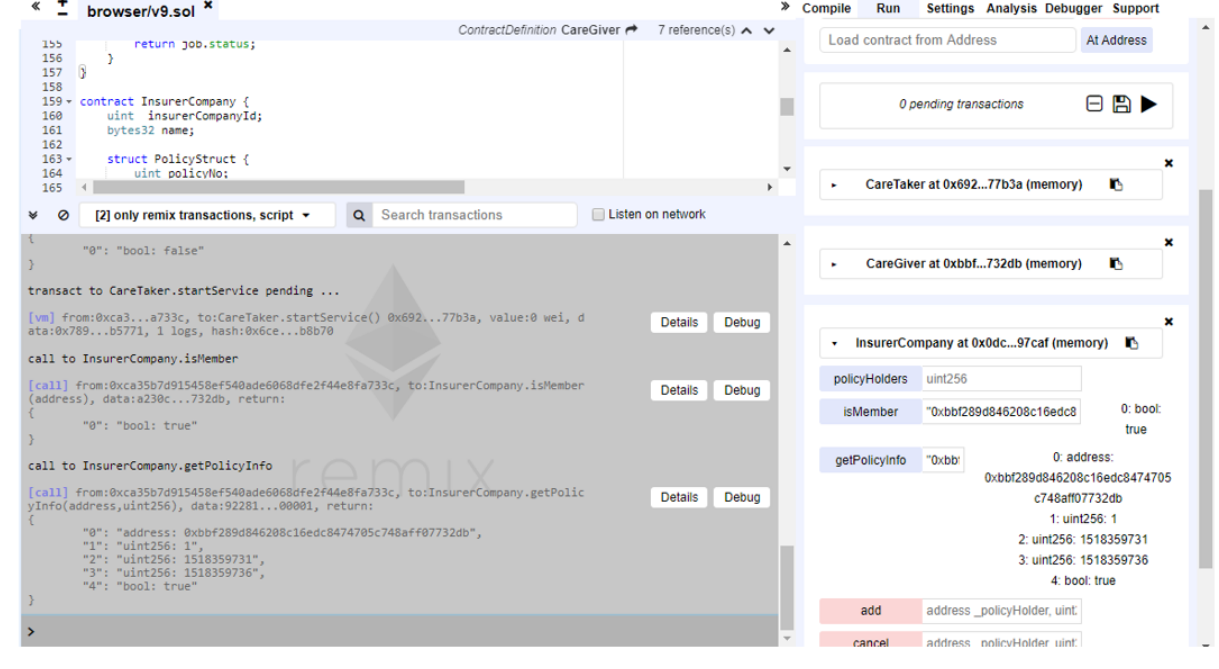
Figure 8. Illustration of the insurance application status after service